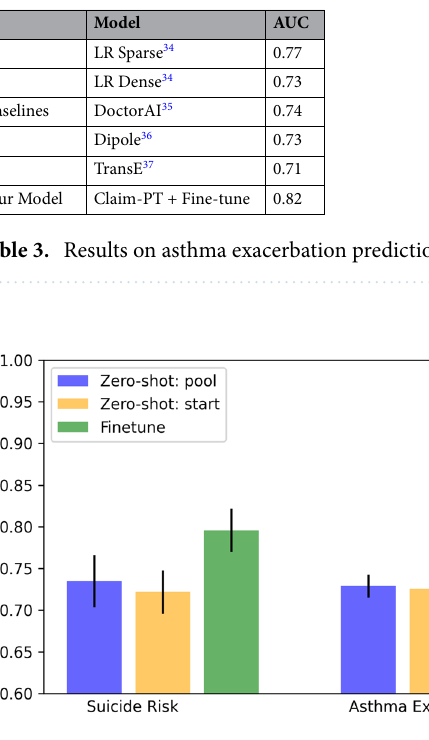
Figure 7. Effectiveness of the pre-training